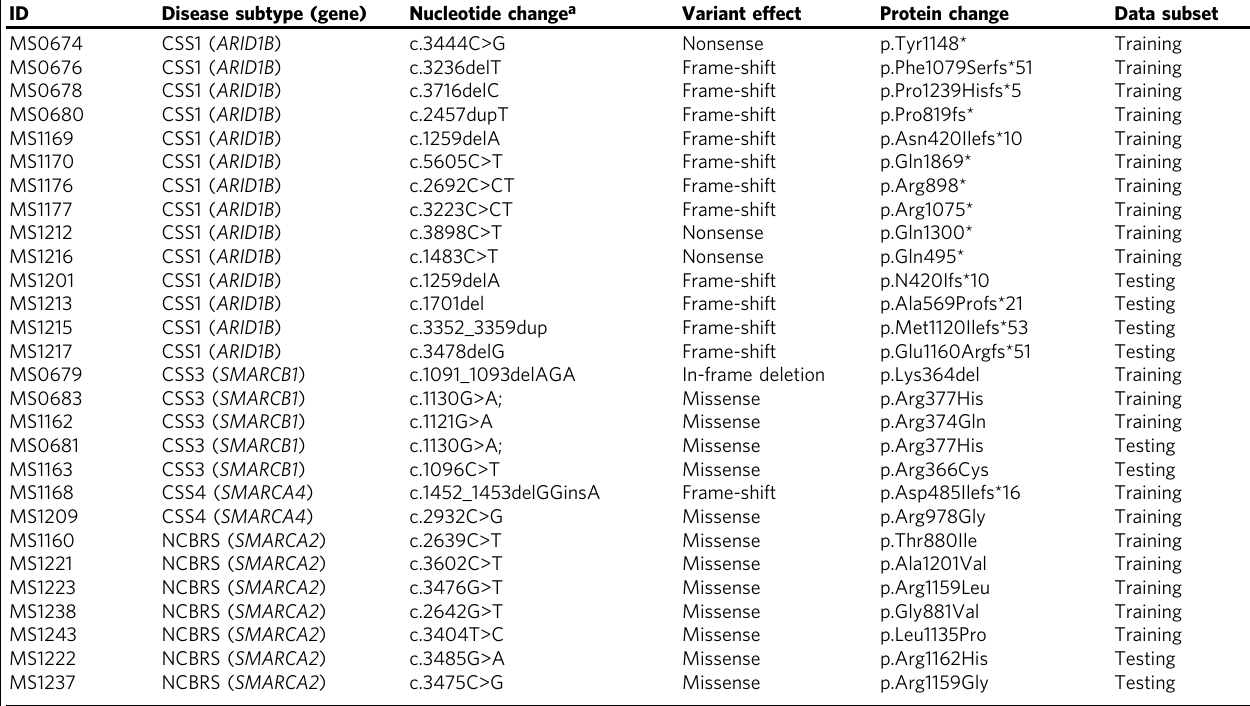
Table 1 Patients with a con fi rmed diagnosis of CSS/NCBRS